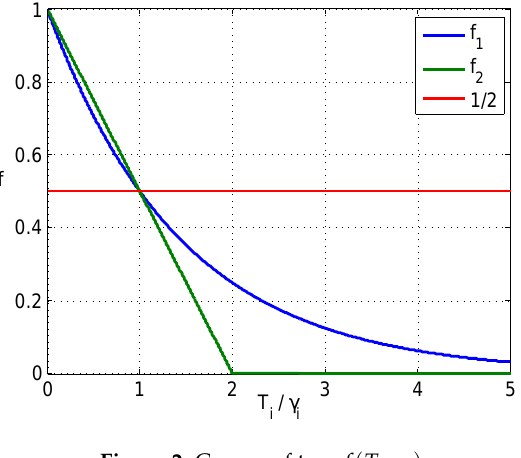
Figure 2. Curves of two f ( T i , γ i )